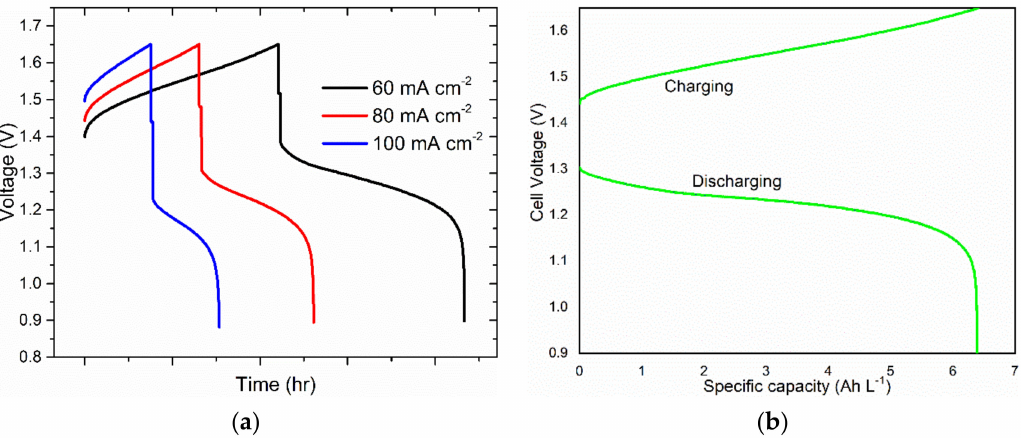
Figure 4. ( a ) Charge and discharge curve at different current densities ( b ) Plot of cell voltage vs. specific capacity of